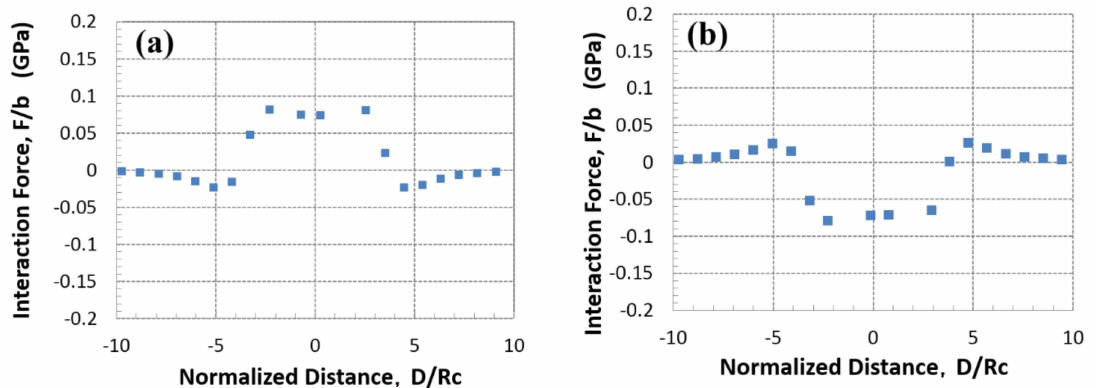
Figure 3. Interaction force acted on screw dislocation intersecting ( − 111) plate in ( a ), (1 − 11) plate in ( b ). Distance from the origin of {111} plate is normalized by radius